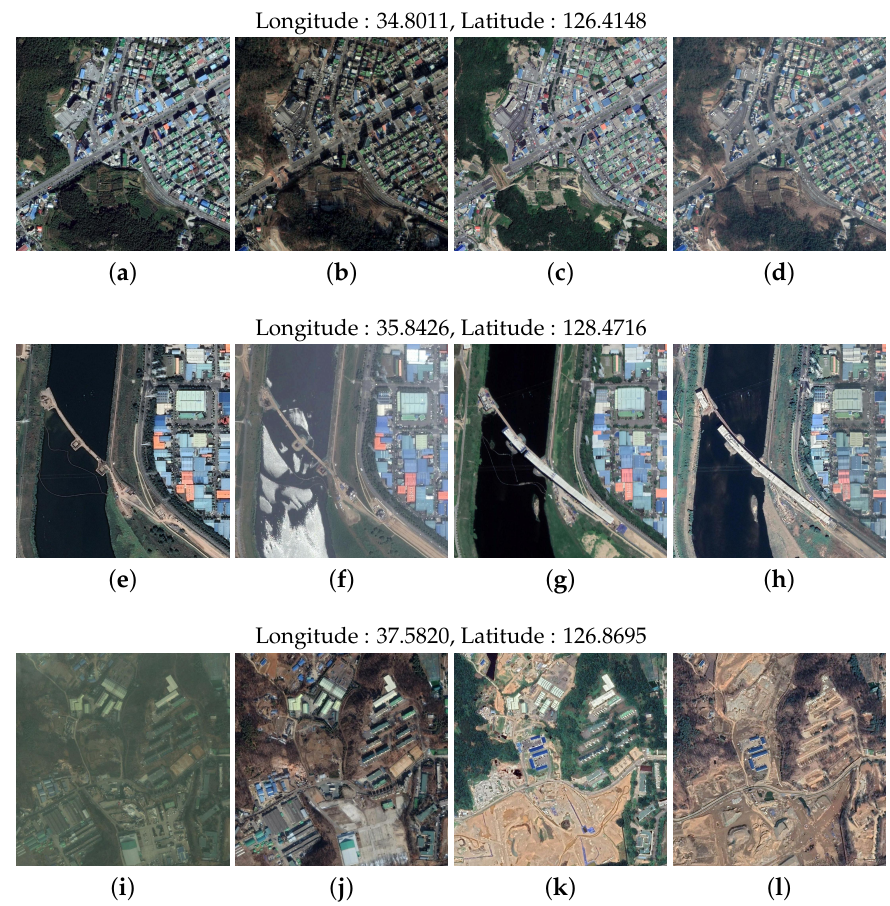
Figure 8. Sample images from the Google Earth South Korea dataset. The photographs were taken in ( a , e , i ) 2016, ( b , f , j ) 2017, ( c , g , k ) 2018, and ( d , h , l )